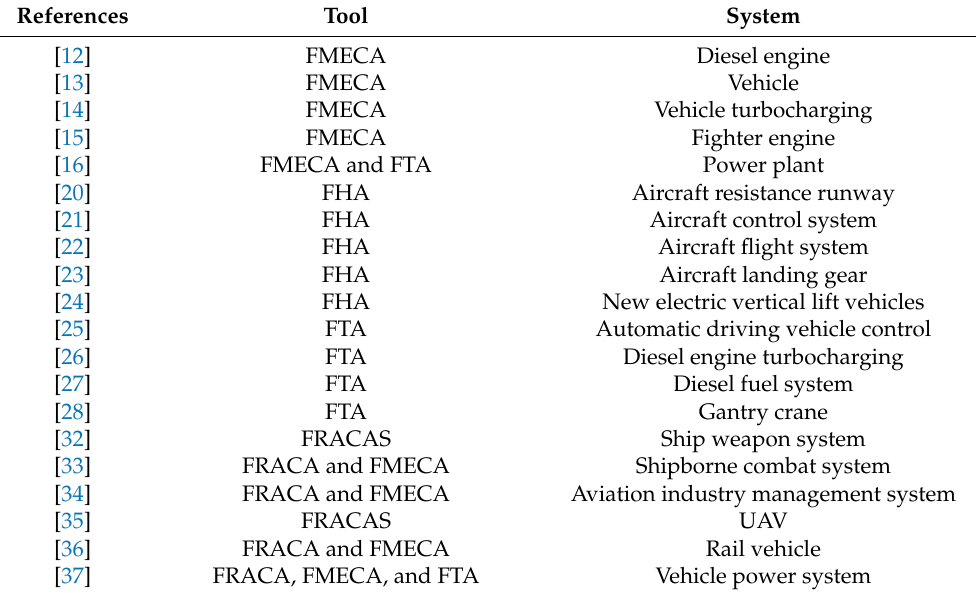
Table 1. Assessment tools for system safety and